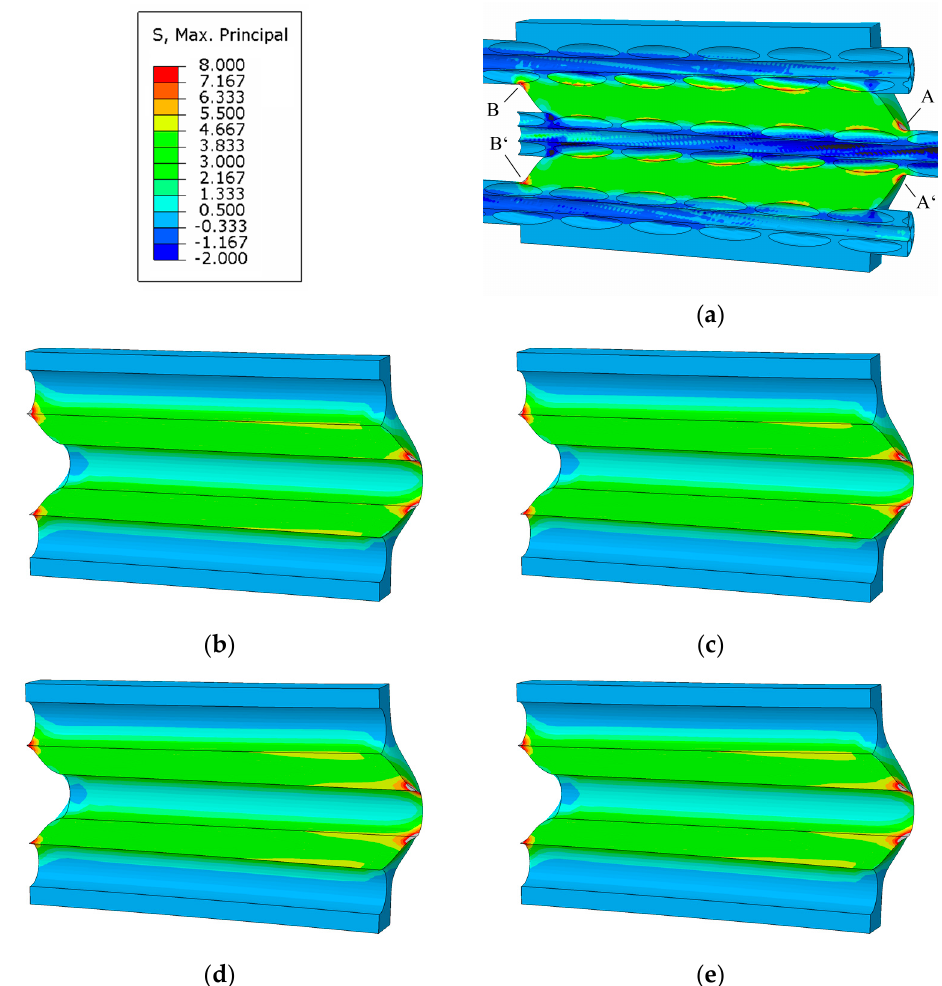
Figure 12. Contour plots of the maximum principal stress σ I (MPa) for ( a ) the full-geometry model and the four efficient cable-modeling approaches ( b ) solid, anisotropic, ( c ) solid, HGO, ( d ) beam, anisotropic, and ( e ) solid/beam, cubic (fit to S ij ). The three-cable szs-type specimens are cut in the plane defined by z = 0.